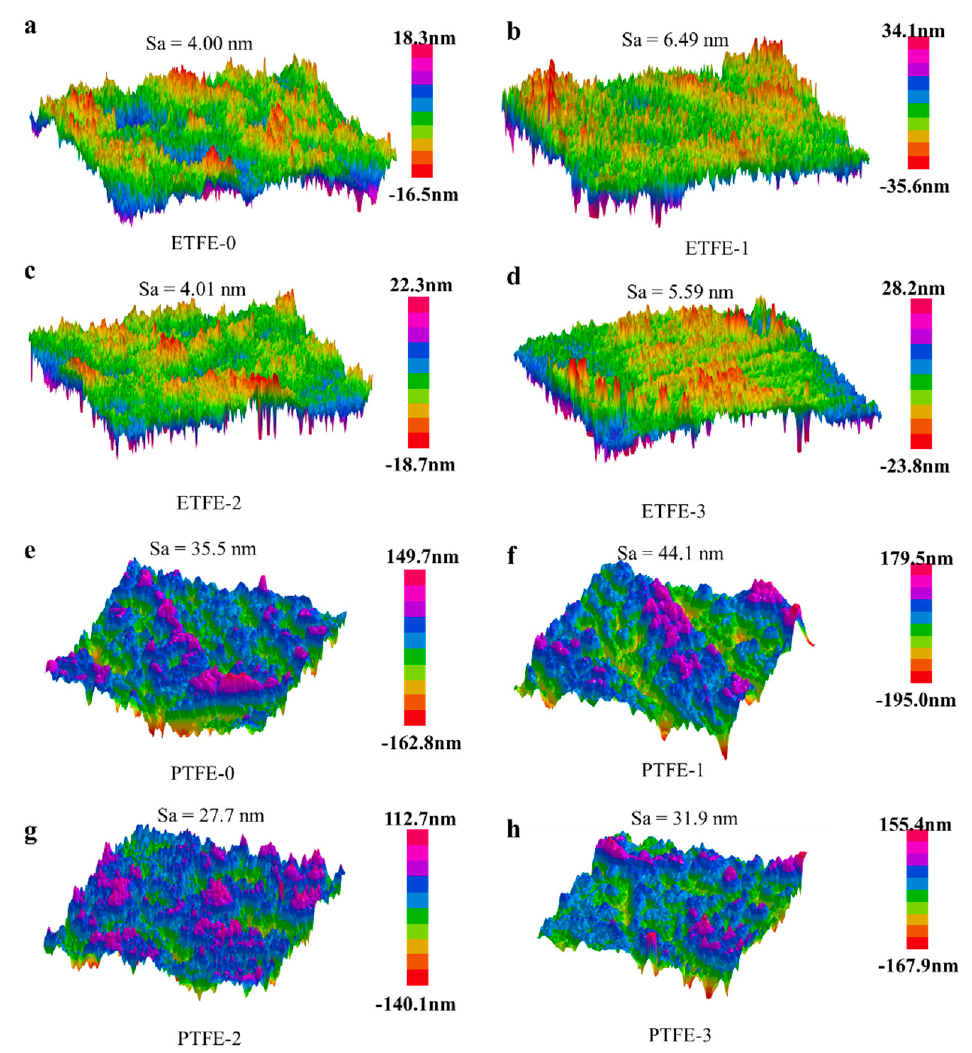
Figure 9. AFM imaging of membranes before and after surface treatment: ( a – d ) ETFE